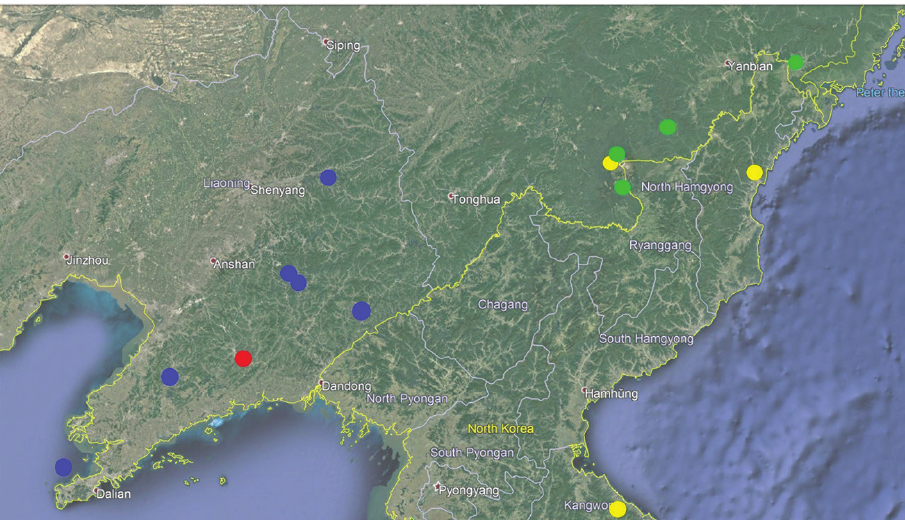
Figure 36. Confirmed distribution of Pterostichus ( Koreonialoe ) spp. in China: Green: P. micropoides sp. nov.; Red: P. tetralobatus sp. nov.; Yellow: P. bellatrix Tschitschérine; Blue: P. syleus